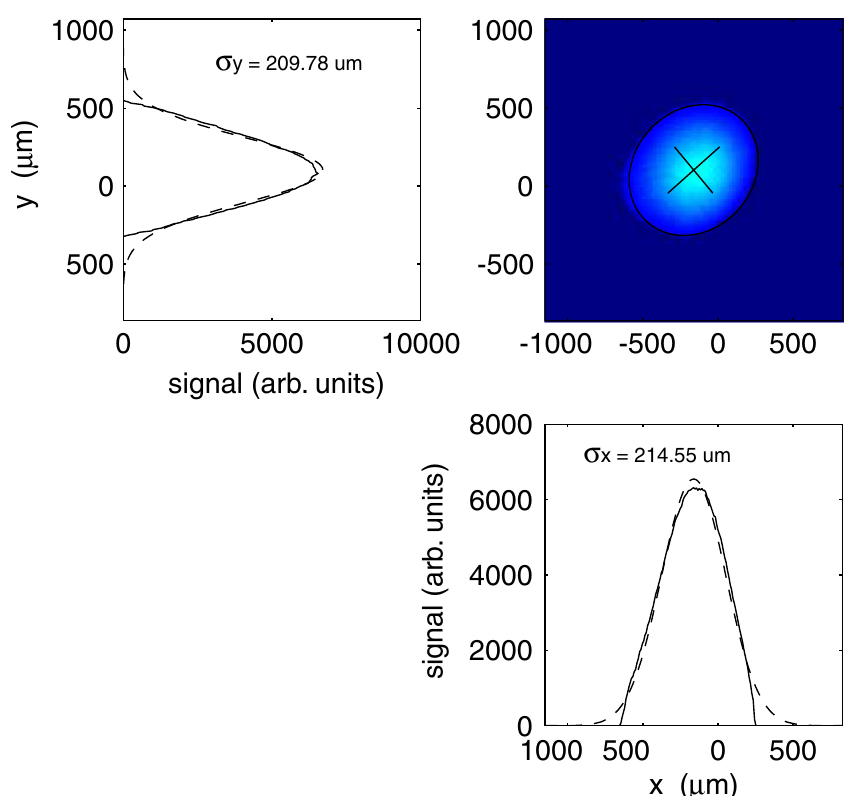
FIG. 7. (Color) The laser spot in the middle of the undulator as imaged by the VHC camera. The solid curves are horizontal ( x ) and vertical ( y ) projections of the image, and the dashed curves are the Gaussian fit for comparison. The base of the image is truncated by the software.